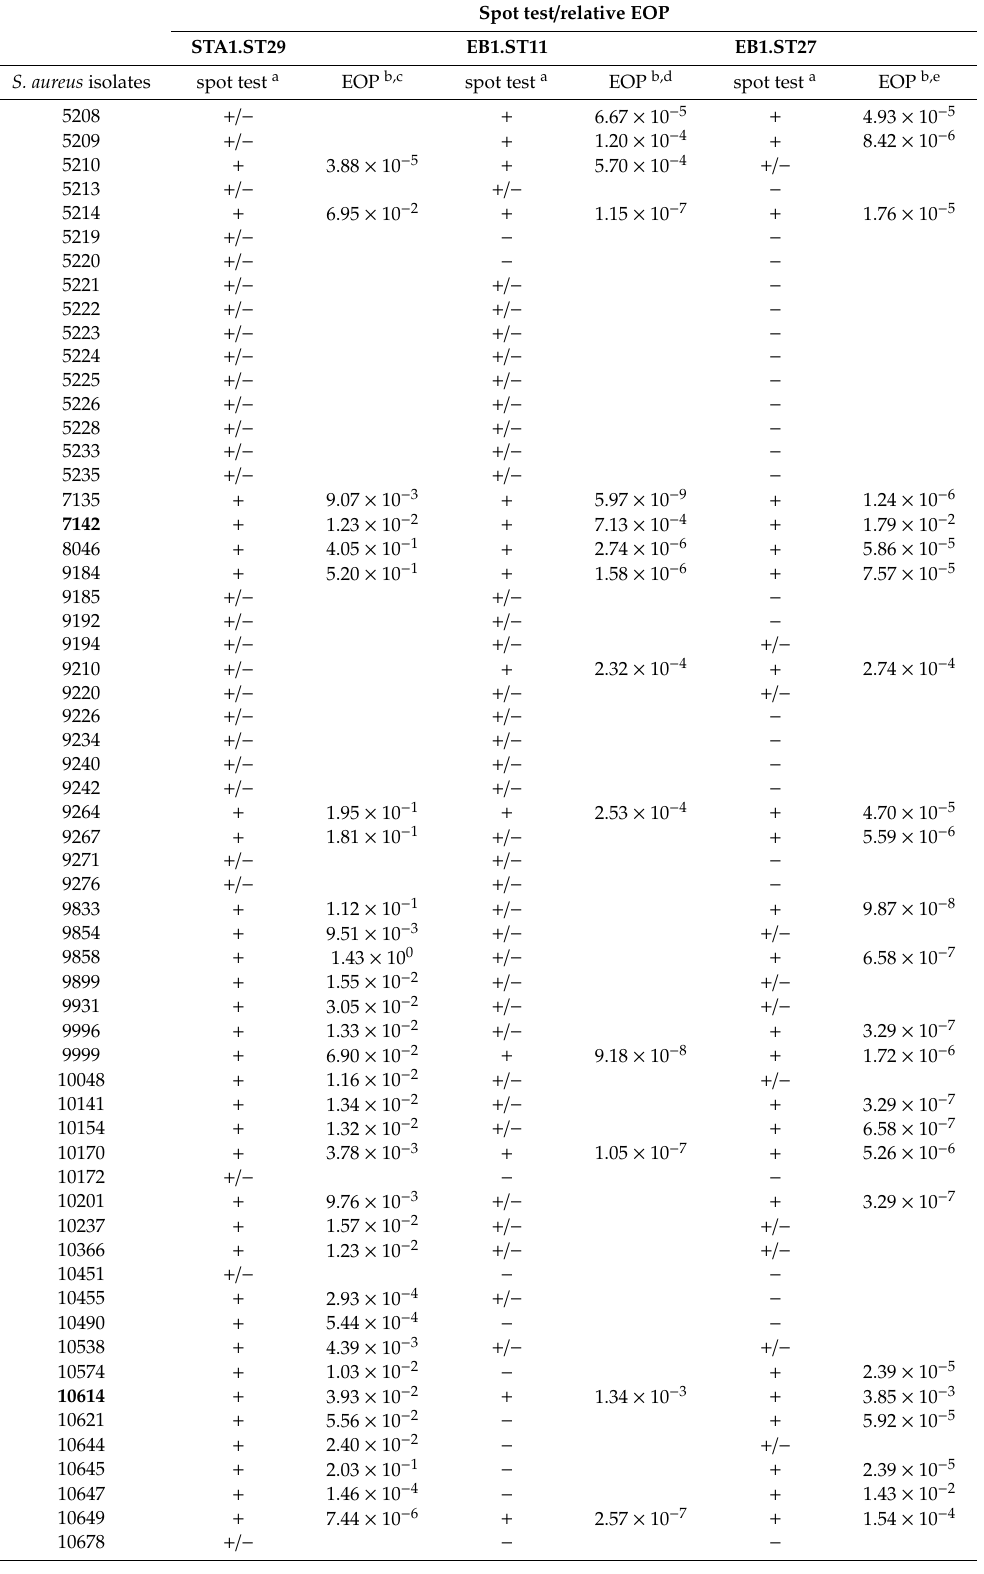
Table 1. Host range of the phages: Results of a spot test and a plaque assay (relative e ffi ciency of plating